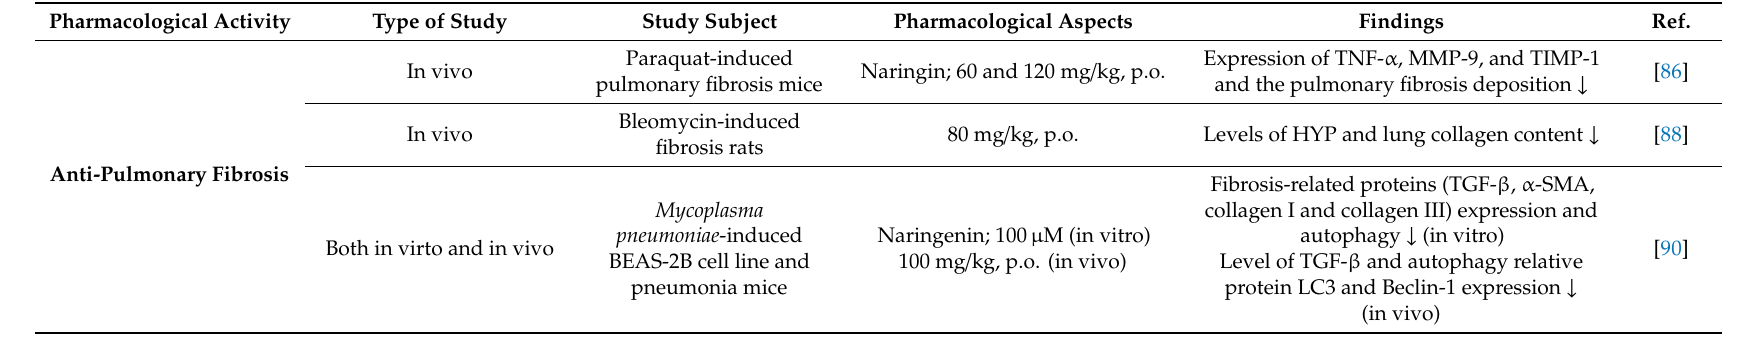
Table 4. Summary of anti-pulmonary fibrosis activities of naringenin and